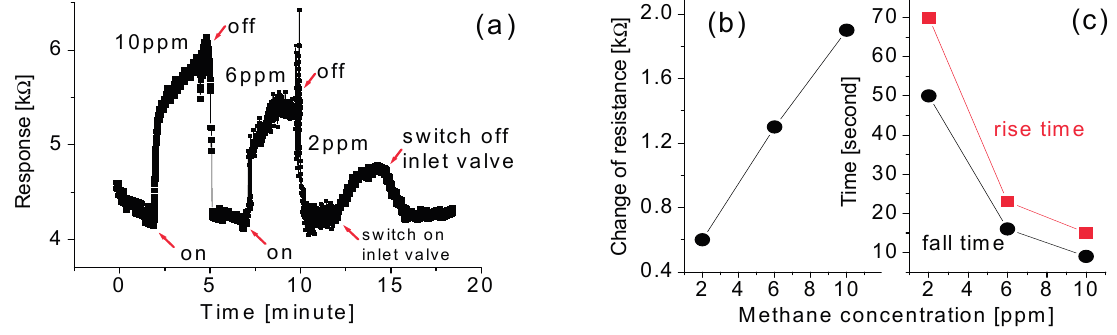
Figure 6. ( a ) The response of the fabricated gas sensor tested at the methane concentrations of 10 ppm, 6 ppm, and 2 ppm, respectively, at room temperature; ( b ) output change (or resistance change); and ( c ) the rise time and fall time as a function of the methane